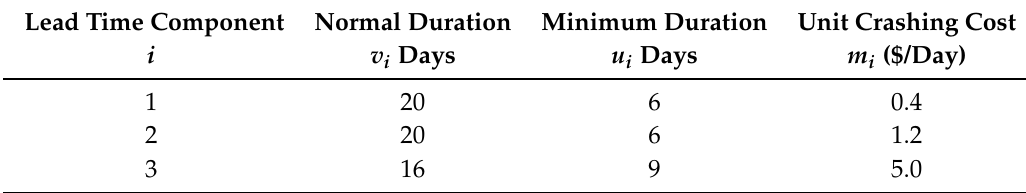
Table 2. Lead time